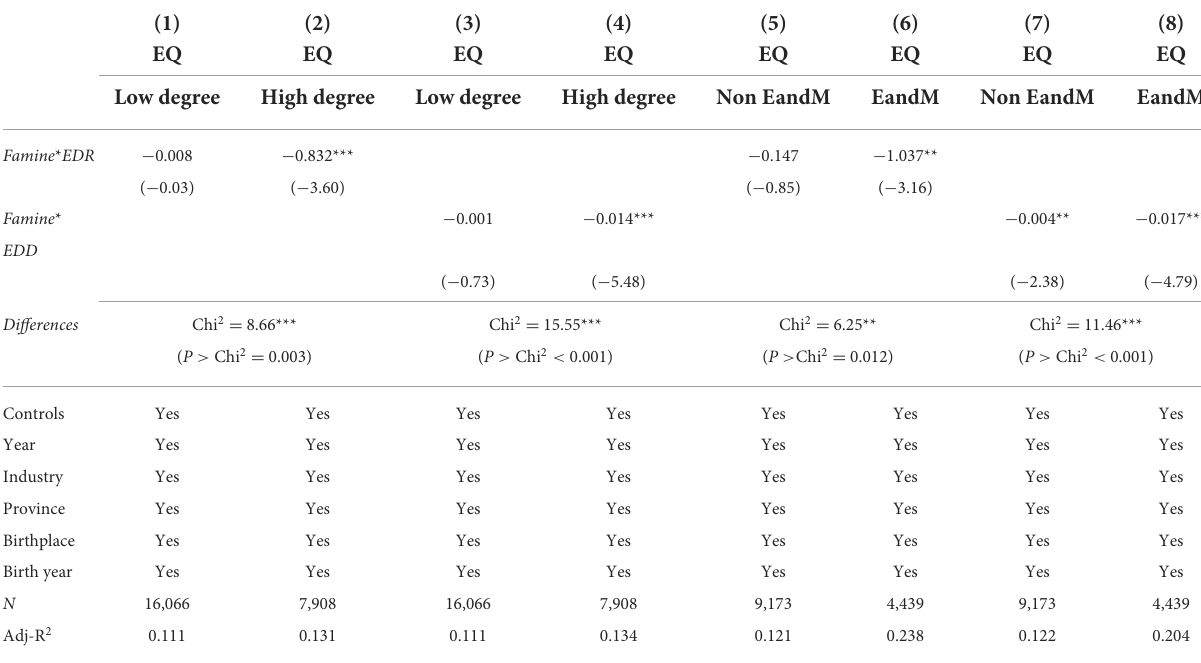
TABLE 13 CEO famine experience and the quality of corporate earnings—a test of famine learning